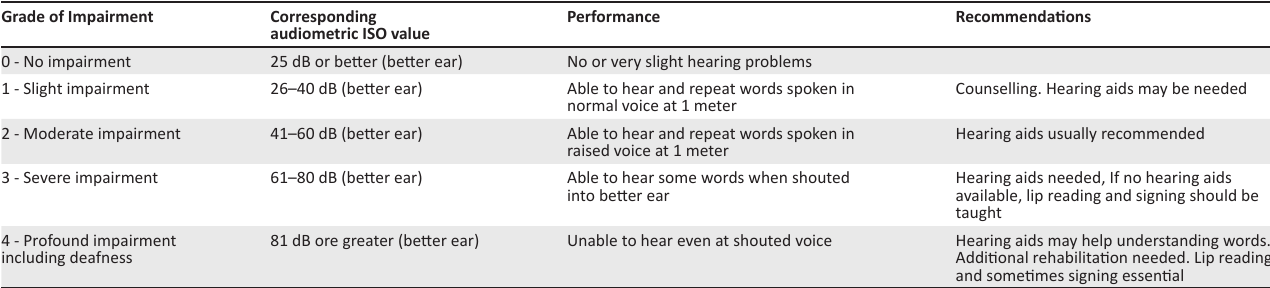
Table 1-A2: WHO Criteria for grading of hearing